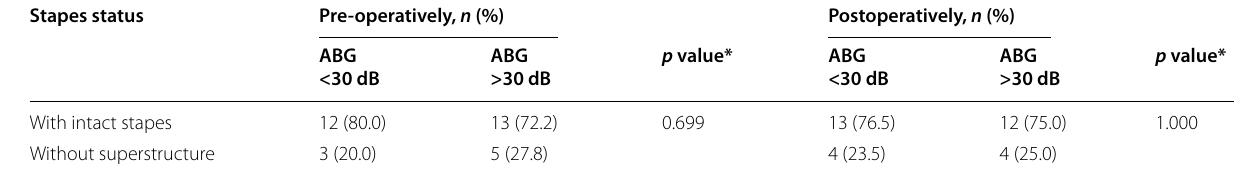
*Pearson chi-square test, significant at p <0.05. Preoperative and postoperative subject, n